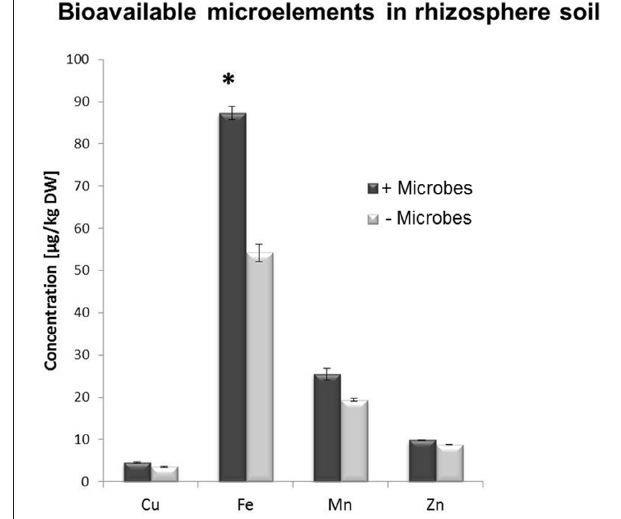
FIGURE 4 | DTPA extraction-based analysis of bioavailable trace element concentrations in rhizosphere soil from Arabidopsis plants grown in the presence or absence of soil microbes. Bars present mean values in μ g/kg of soil dry weight (DW) ± SE from 3 independent replicates (pooled rhizosphere soil from 50 plants/replicate). The asterisk indicates a statistically significant difference ( P < 0 . 05).